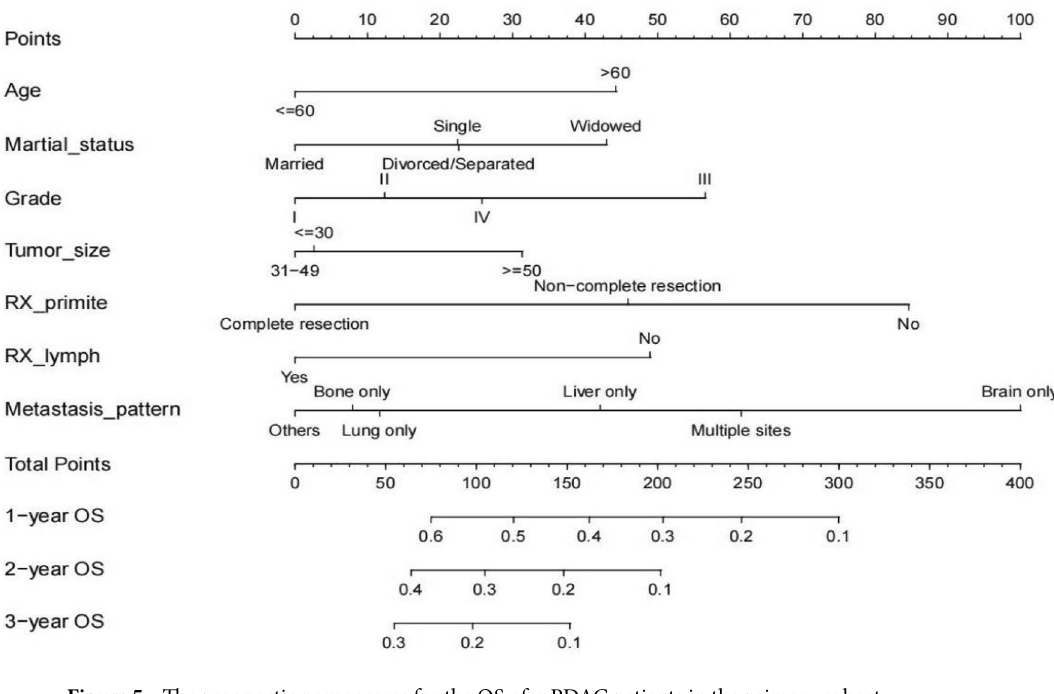
Figure 5. The prognostic nomograms for the OS of mPDAC patients in the primary cohort.